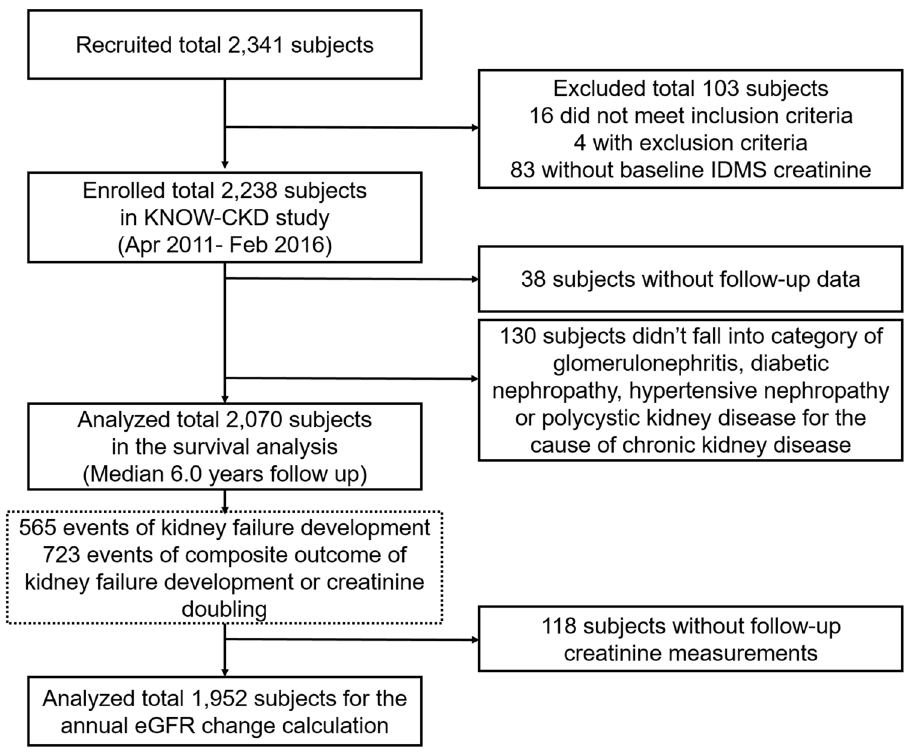
Figure 1. Flowchart of enrolled study patients. eGFR, estimated glomerular filtration rate; IDMS, isotope dilution mass